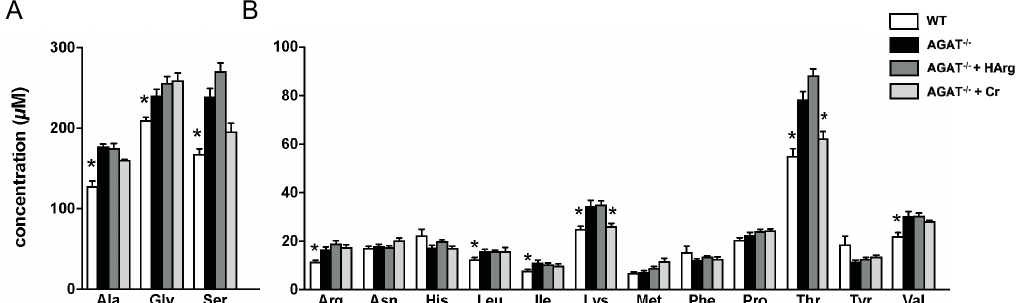
Figure 7. Amino acid analysis in brain tissue of WT, AGAT − / − , AGAT − / − Cr and AGAT − / − hArg mice. ( A ) Amino acids with high concentrations. ( B ) Amino acids with lower concentrations. * p < 0.05 versus AGAT − / − . Mann–Whitney U-test. Adjustment for multiple testing by Benjamini–Hochberg method. False discovery rate ≤ 0.05. Amino acid abbreviations are in three letter code.